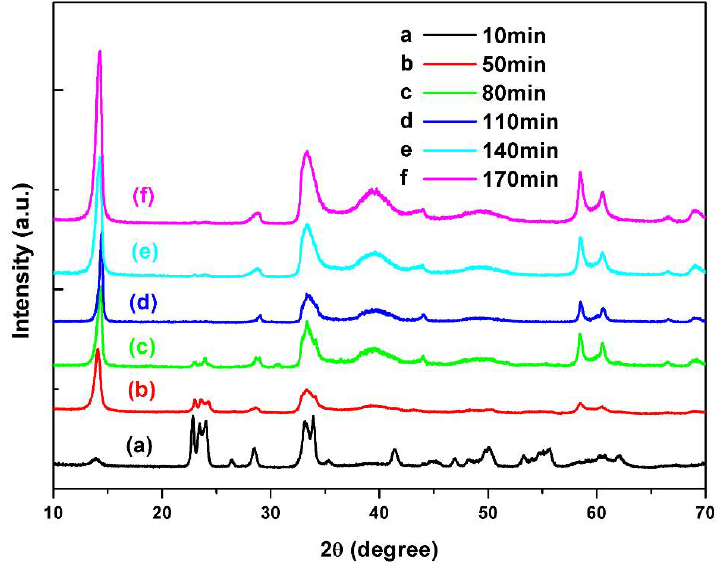
Figure 9. XRD profiles of samples from experiments A–F, demonstrating the effect of different reaction time at 800 °C from 10–170 min.